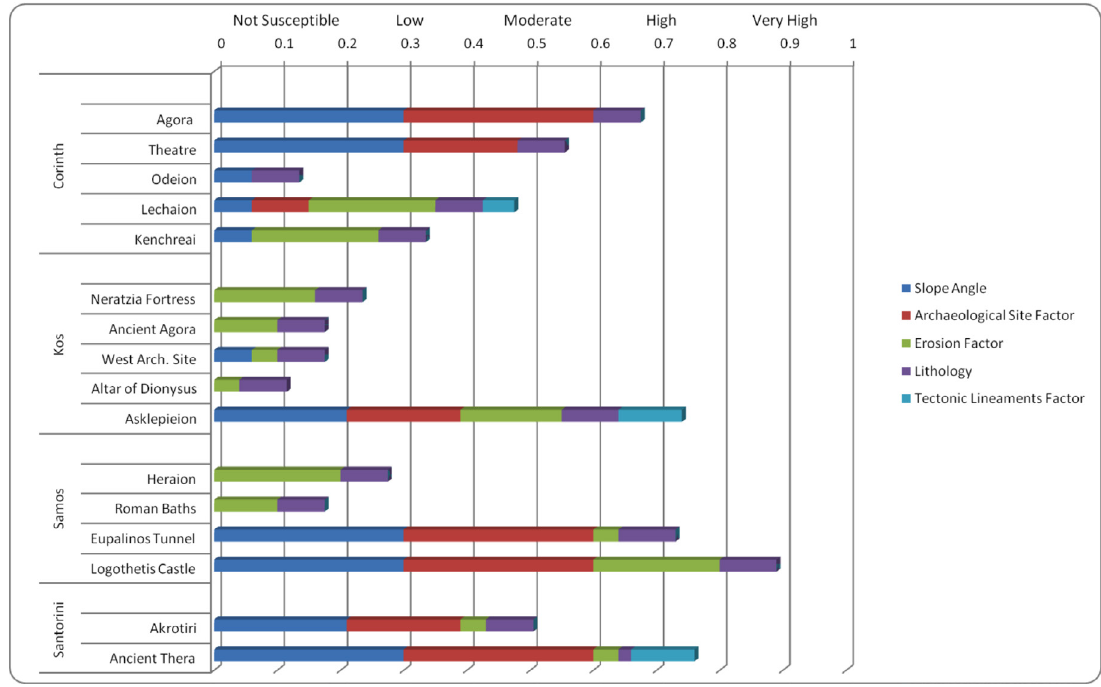
Figure 4. The Landslide Susceptibility indicator diagram for the archaeological sites under